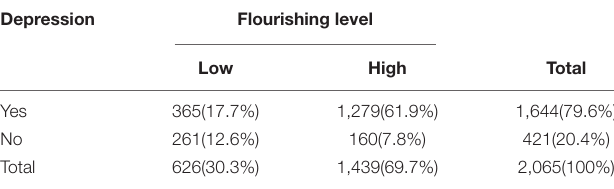
TABLE 1 | Proportion of college students’ mental health groups. TABLE 2 | Six categories of college students’ mental